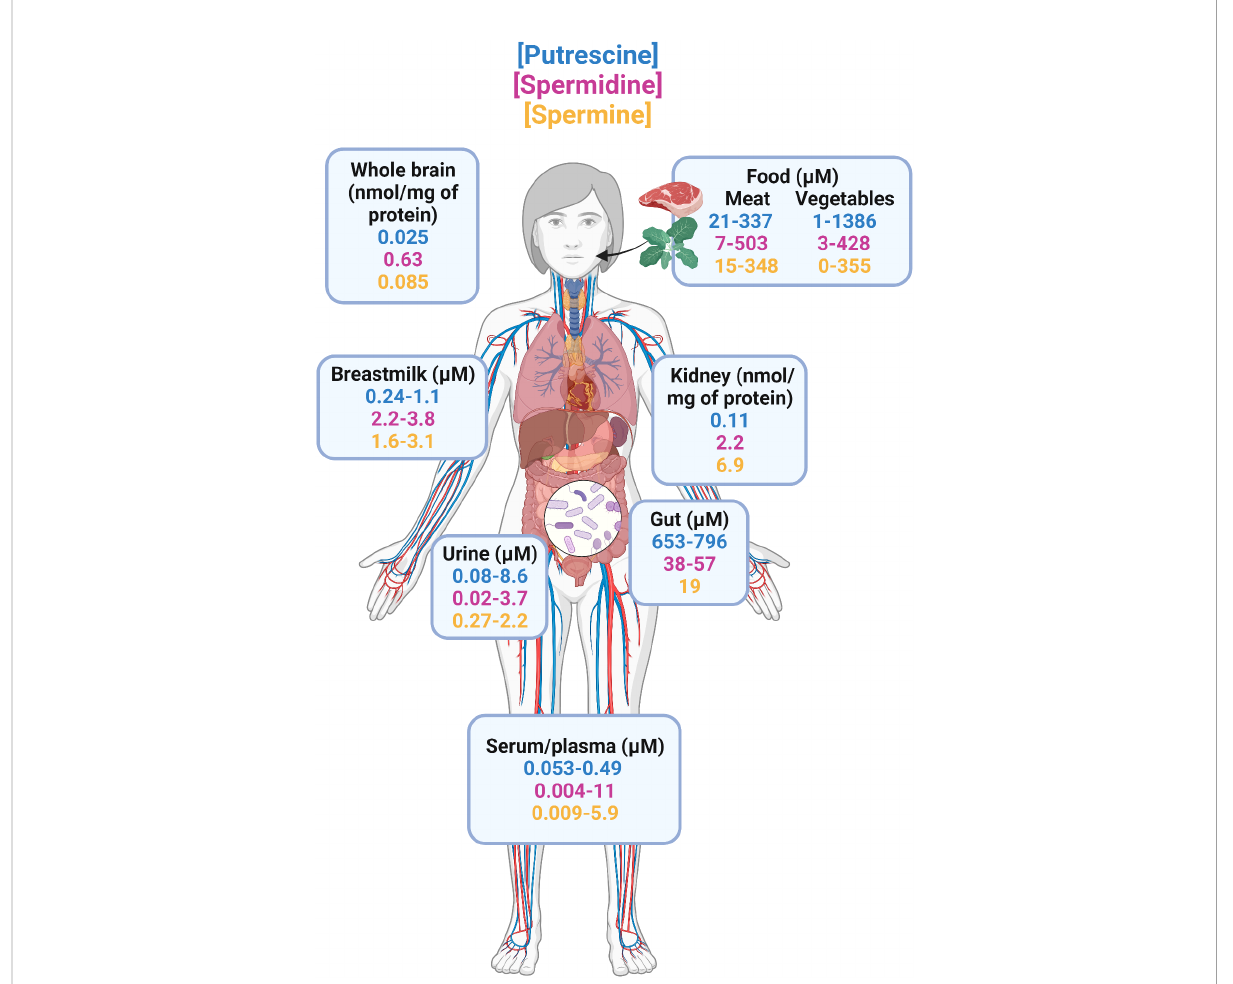
FIGURE 1 Distribution of natural polyamines in healthy adults. The three most abundant polyamines in humans are putrescine, spermidine, and spermine. Total polyamine is highest in the intestine because diet and gut microbiome are the primary sources of polyamines. From the gastrointestinal tract, polyamines are readily absorbed and enter circulation where they are found in a variety of organs including the brain, kidneys, and in metabolic fl uids such as urine, and breastmilk. Studies that reported concentrations in ng/mL or m g/mL were transformed to m M using the molecular weights of putrescine (88.15 g/mol), spermidine (145.25 g/mol), and spermine (202.34 g/mol) for better